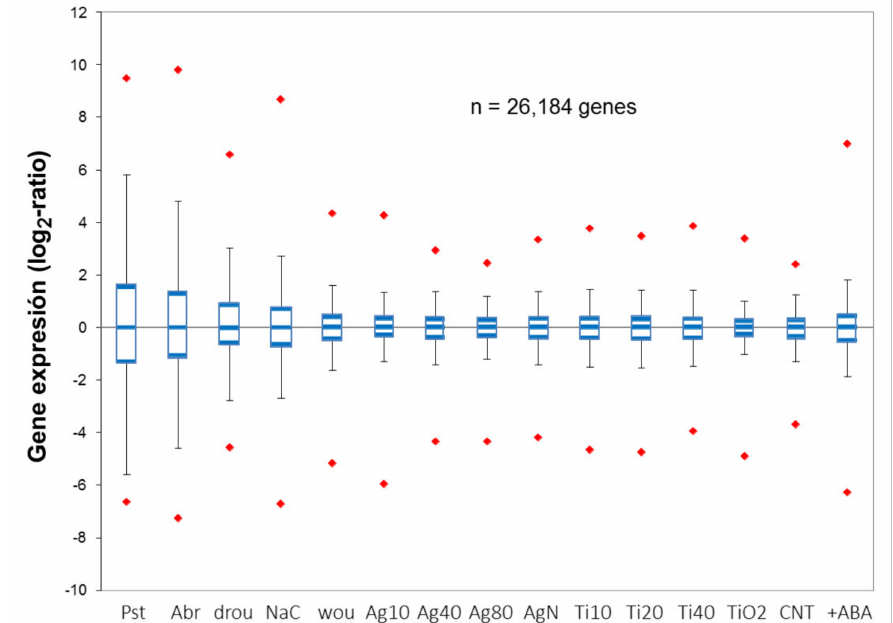
Figure 3. Box-plot distribution of the expression ratios from 26,184 genes represented in AtV4 microarrays [34]. Boxes represent 10th and 90th percentiles, with the median (Q2) in the middle line of the box. Minimum and maximum values are shown by the end of the vertical lines (whiskers) and upper or lower outliers by red diamonds. Pst and Abr denote biotic stress by bacteria or fungi, respectively. drou , NaC , and wou abiotic stress by drought, salt, and wounding. Ag20 , Ag40 , Ag80 , and AgN represent the addition of Ag-NPs of 10-, 20-, 40- and 80-nm diameter, or AgNO 3 bulk material, respectively. Ti10 , Ti20 , Ti40 , and TiO2 indicate the addition of TiO 2 -NPs of 10-, 20-, 40-nm diameter, or TiO 2 . CNT and +ABA indicate the addition of CNTs or CNTs plus